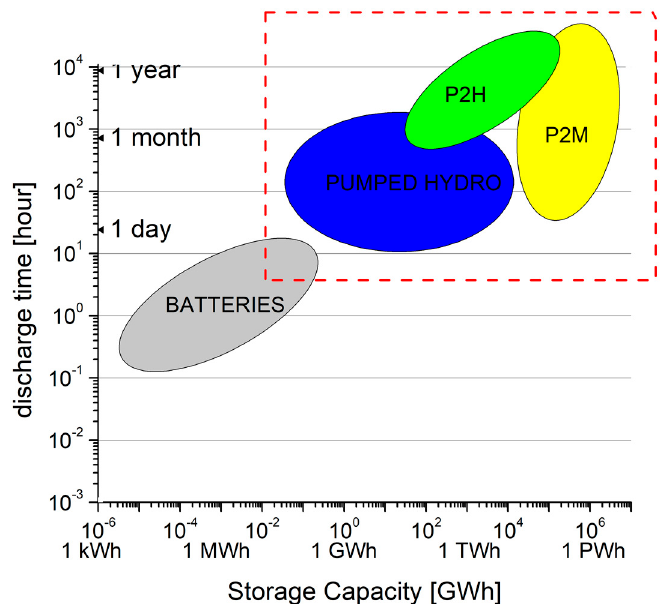
Figure 1. Schematic discharge time vs. storage capacity diagram for various storage methods, including batteries, pumped hydro, Power-to-Hydrogen and Power-to-Methane [5]. Long-term storage solutions are located inside the dashed rectangle.